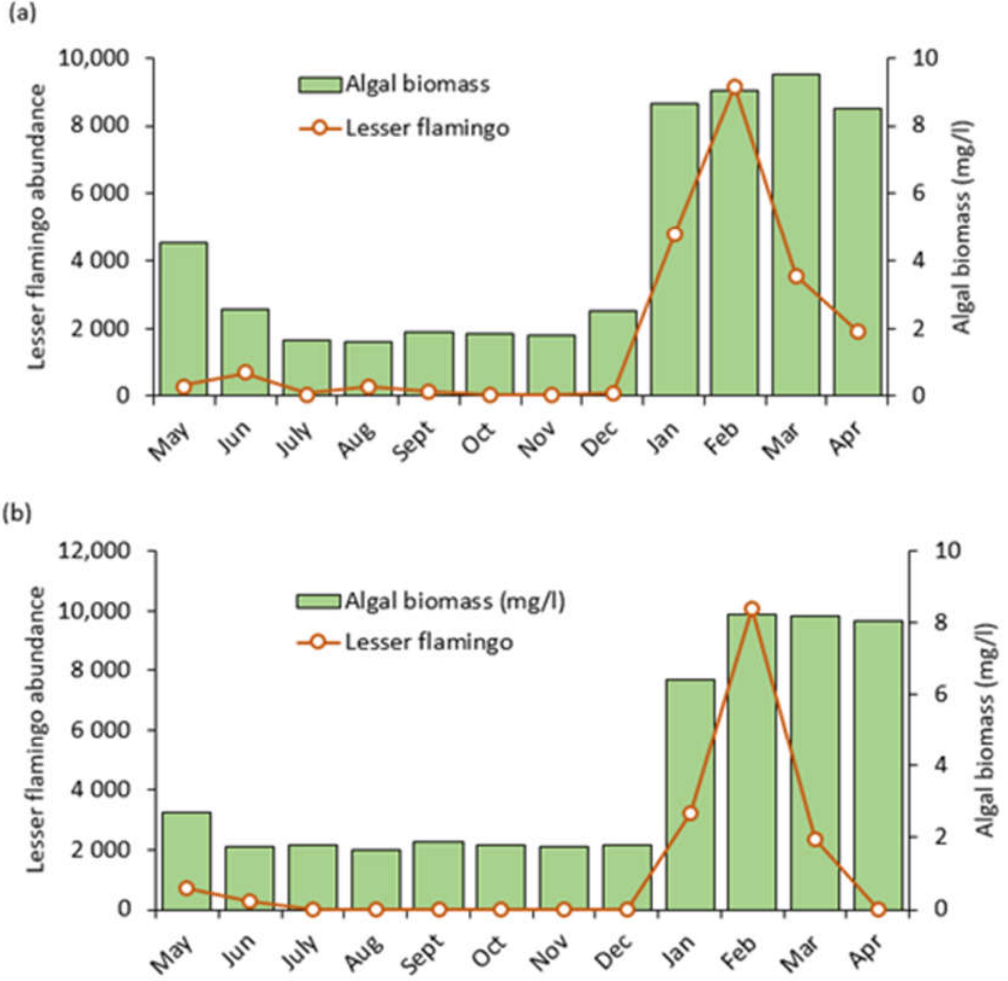
Figure 8. Lesser flamingo abundance (monthly number of individuals counted) and algal biomass trends as monitored from May 2020 to April 2021 at lakes; ( a ) Big Momella and ( b ) Rishateni, northern Tanzania.